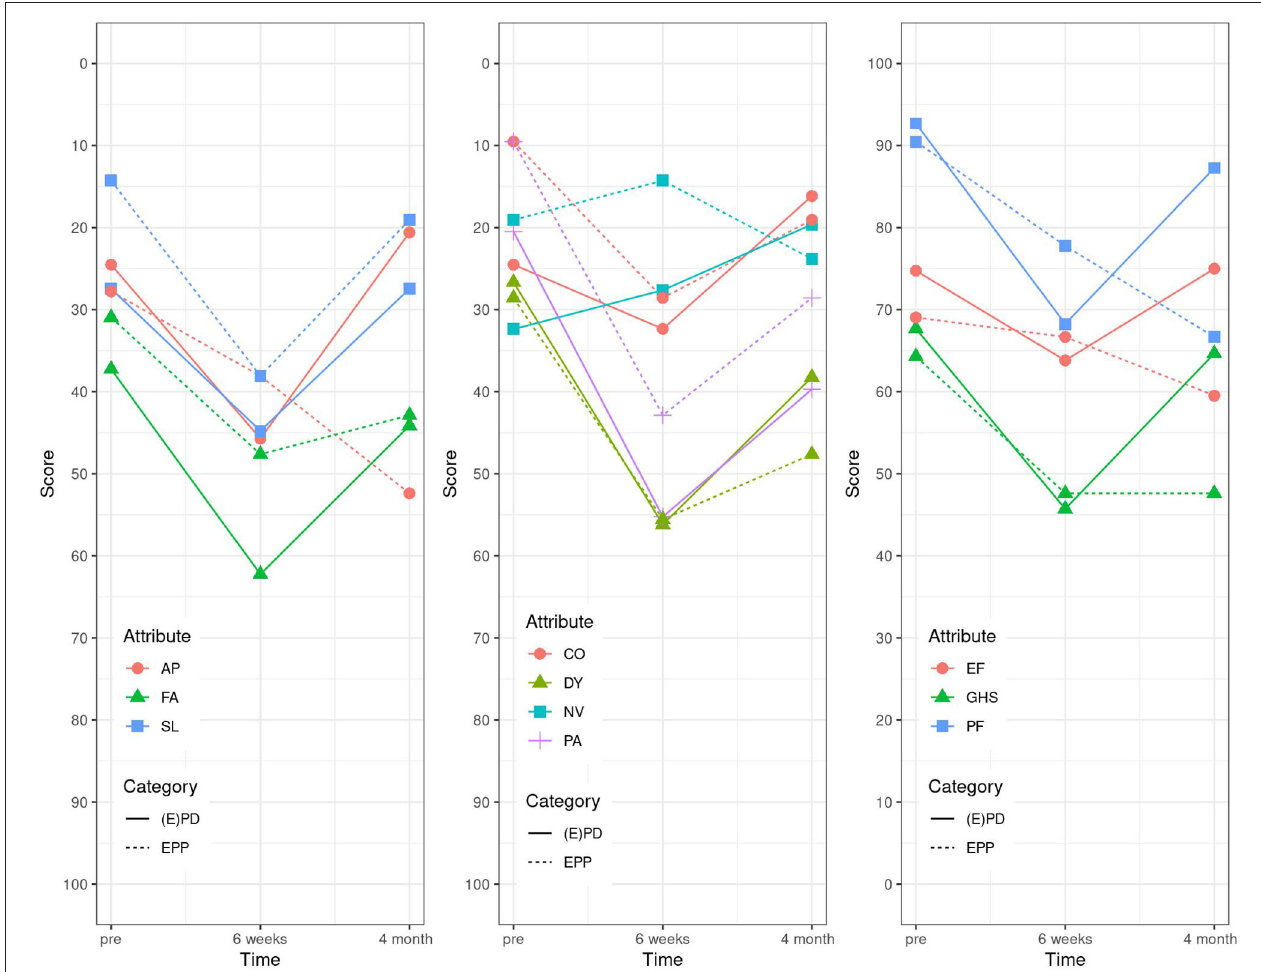
FIGURE 3 | Linear graphs. EORTC C15 (2006): “not at all” corresponding to 0 and “very much” to 100. GHS, global health status; PF, physical functioning; EF, emotional functioning; FA, fatigue; NV, nausea and vomiting; PA, pain; DY, dyspnea; SL, insomnia; AP, appetite loss; CO, constipation.